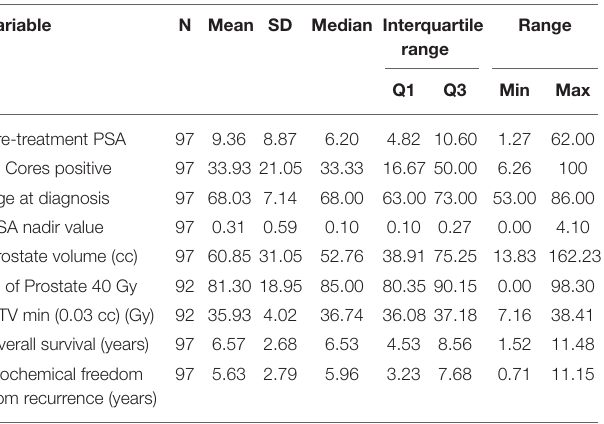
TABLE 1 | Descriptive statistics for continuous variables.